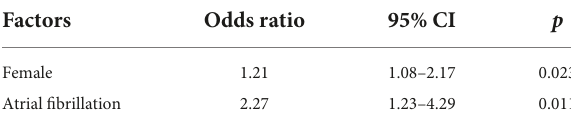
TABLE 4 Multivariate analysis of predictors of TTR <